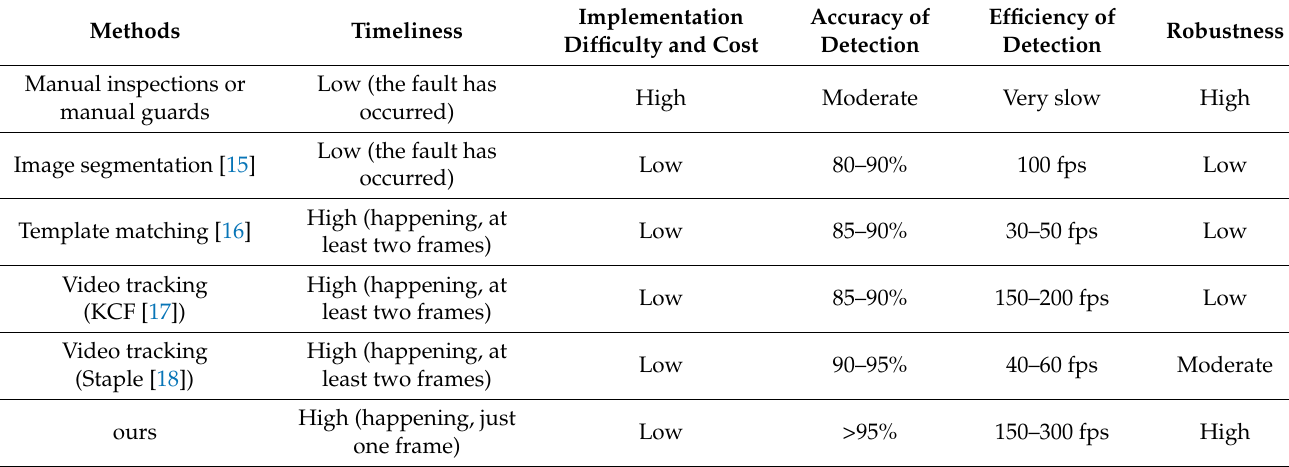
Table 1. Existing detection methods for rope arrangement